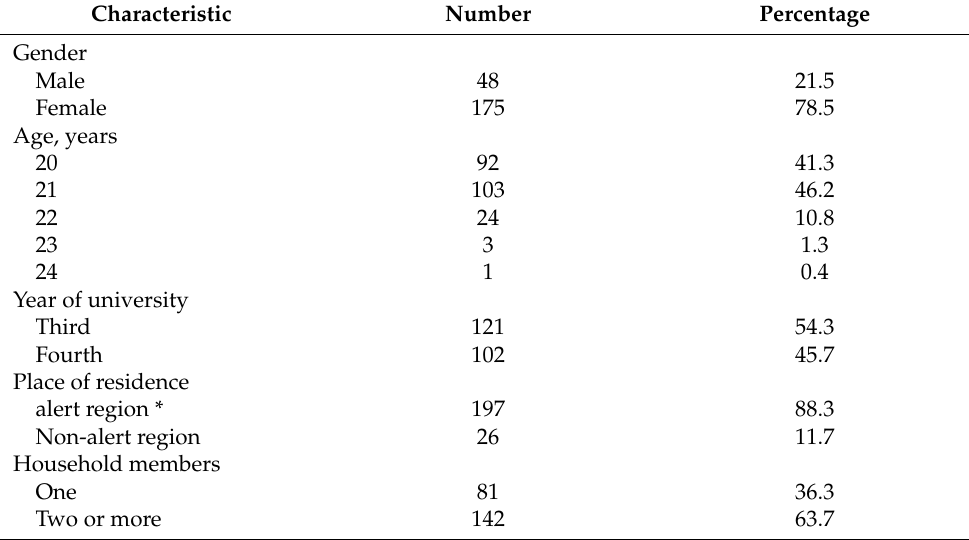
Table 1. Demographic characteristic of the study participations (n =